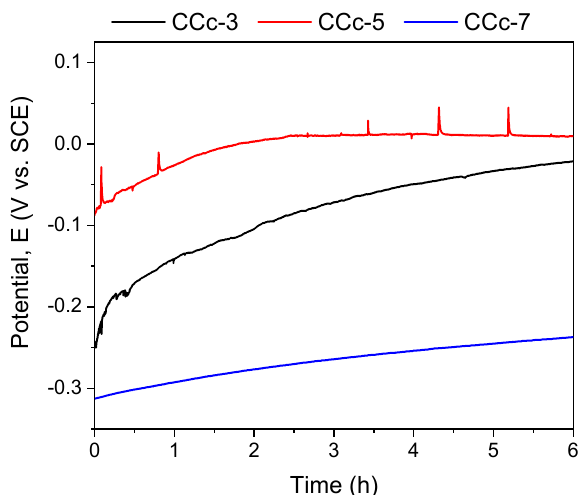
Figure 7. Open circuit potential evolution corresponding to the cast CoCr alloy in all testing media.